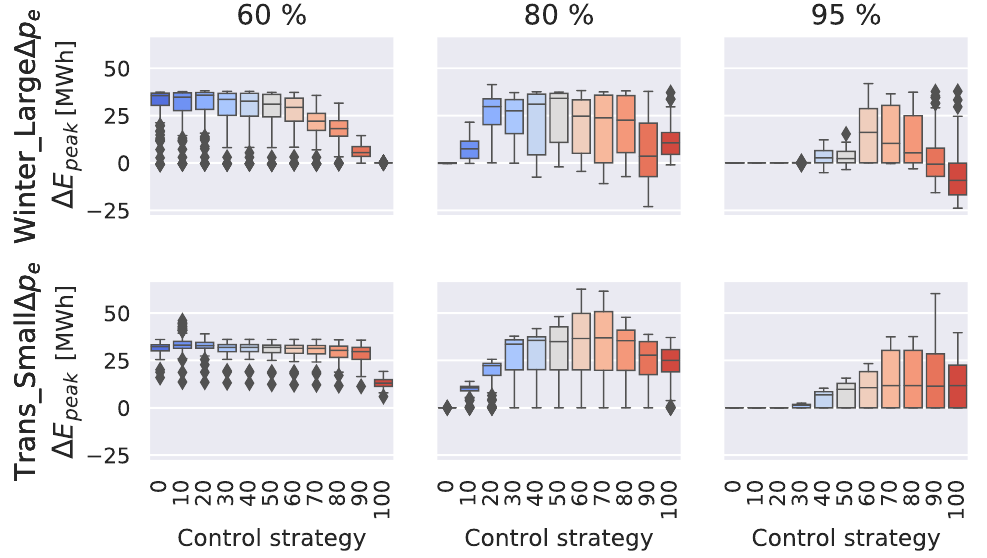
Figure 10. Box plots of the avoided peak energy with the 11 selected control strategies on all 100 versions of GenkNET for Winter_Large ∆ p e and Trans_Small ∆ p e and for different base load